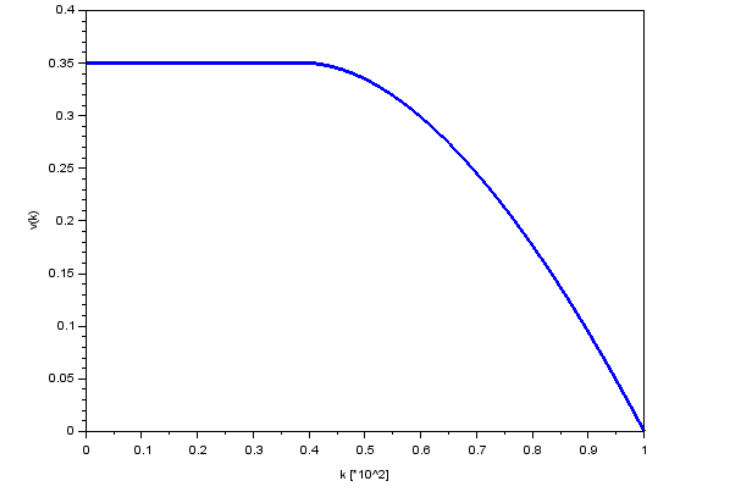
Figure 1. Value function for the special